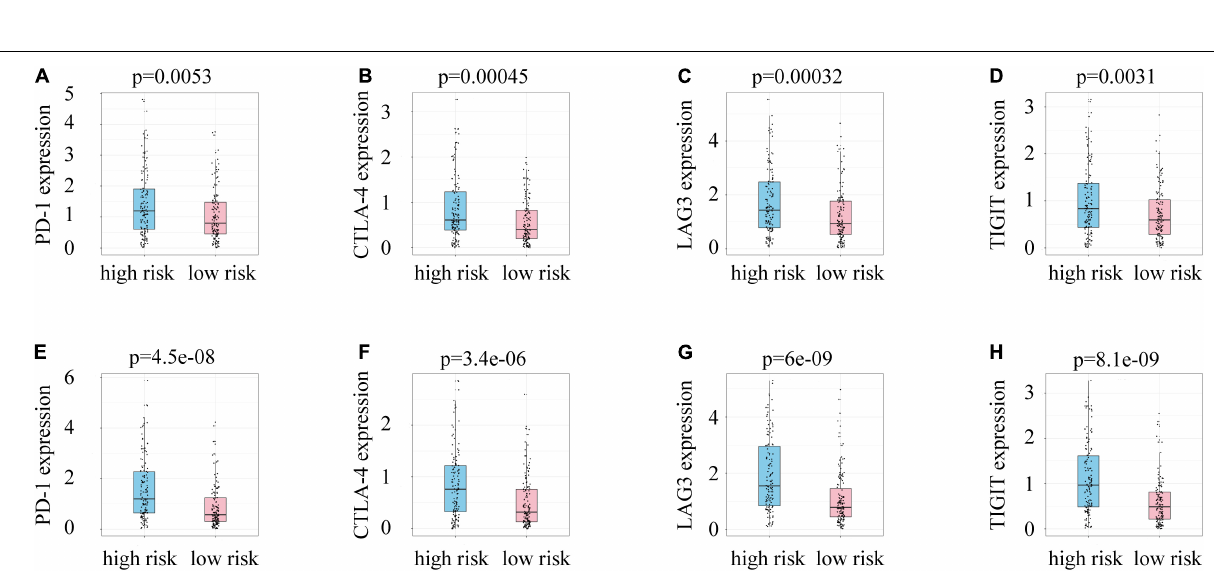
FIGURE 7 | (A) PD-1 expression and risk scores in the training group. (B) CTLA-4 expression and risk scores in the training group. (C) LAG3 expression and risk scores in the training group. (D) TIGIT expression and risk scores in the training group. (E) PD-1 expression and risk scores in the test group. (F) CTLA-4 expression and risk scores in the test group. (G) LAG3 expression and risk scores in the test group. (H) TIGIT expression and risk scores in the test